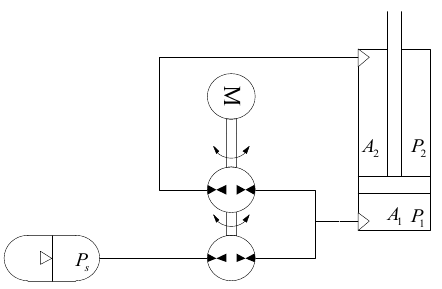
Figure 4. The basic schematic diagram of the direct drive hydraulic system adopted in this paper For direct drive system, rotation speed of the servo motor is usually selected as the control input.